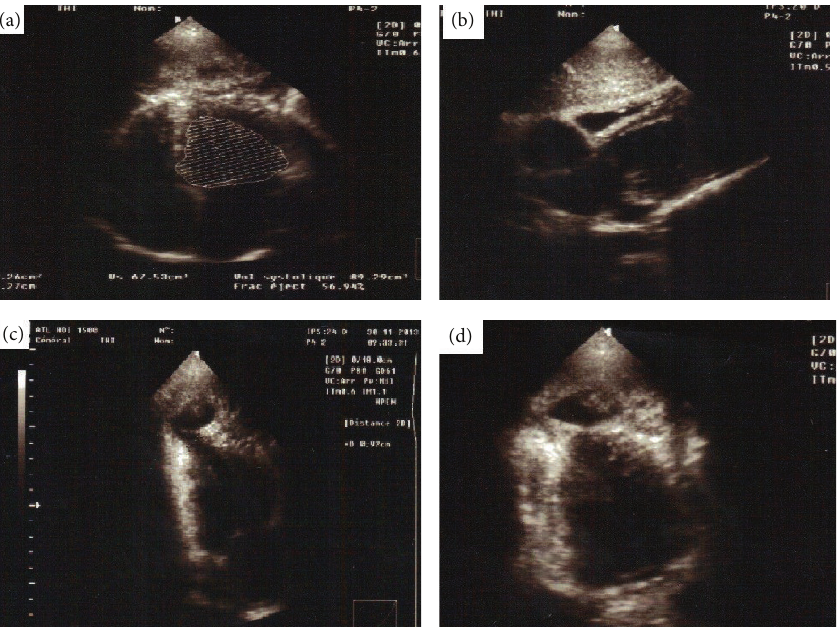
Figure 2: Cardiac ultrasound findings. (a) Calculation of ejection fraction from 57% in Simpson 4 cavities. (b) Cutting subcostal objectifying the left ventricle and the pseudoaneurysm with no notion of communication. ((c) and (d)) Apical view: collar diameter was 9 mm, and presence of a heterogeneous structure suggestive of thrombus lining the pseudoaneurysm was